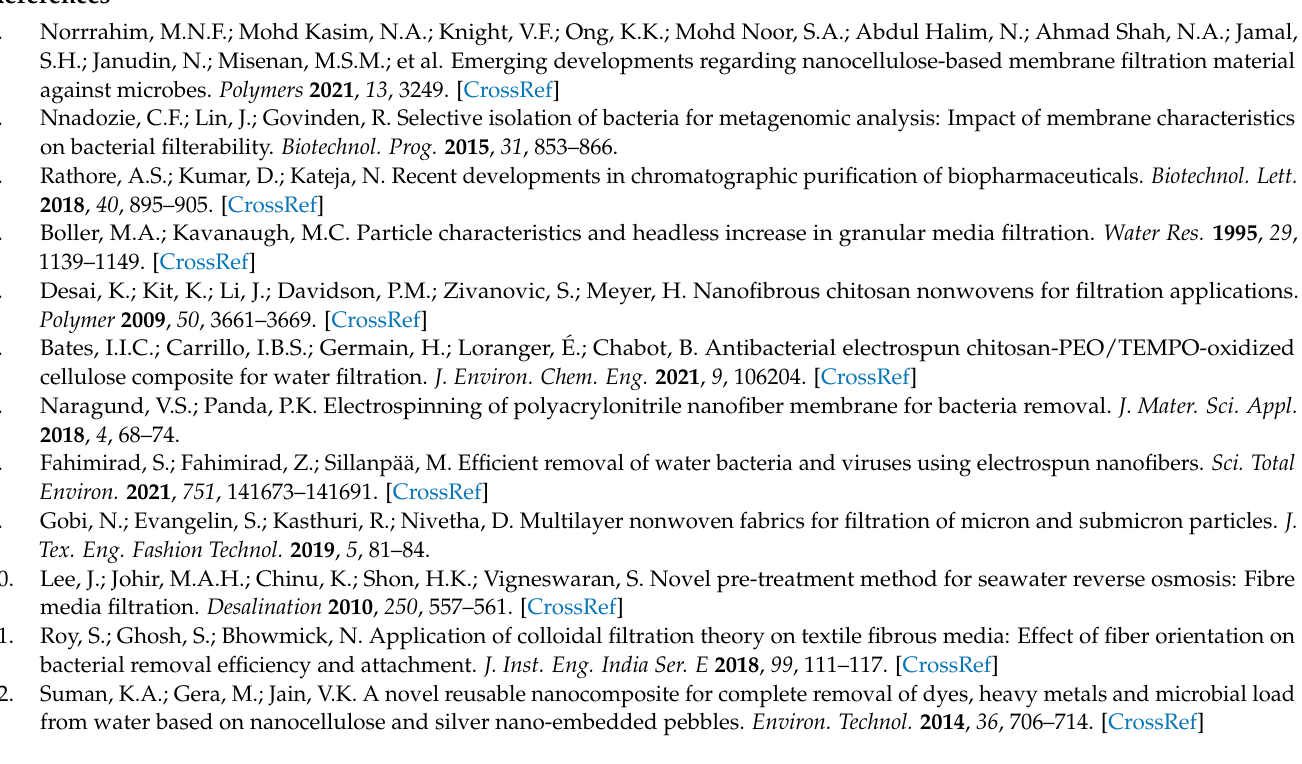
(A) Escherichia coli (EXB-V127), (B) Staphylococcus aureus (EXB-V54), and (C) Micrococcus luteus (EXB-V52); Figure S3: Four individual (i.e., single-layer) fibrous membranes of the same type (each impregnated with 50 mL of 0.1 wt% quaternised cellulose nanofibrils) tested as 4-layer sandwich- structured membranes in a vacuum filtration performance assay with bacterial cell suspensions of (A) Micrococcus luteus (EXB-V52) and (B) Escherichia coli (EXB-V127); Figure S4: Four individual (single-layer) fibrous membranes (each impregnated with 50 mL of 0.1 wt% quaternised cellulose nanofibrils (qCNF), with and without the addition of 0.1, 0.2 or 0.3 wt% amino-hydrophobised CNF (aCNF)) after testing as 4-layer sandwich-structured membranes in a vacuum filtration performance assay with bacterial cell suspension of (A) Escherichia coli (EXB-V127) and (B) Staphylococcus aureus (EXB-V54); Table S1: Overview of the final nominal concentrations of the quaternised (qCNF) and amino-hydrophobised cellulose nanofibrils (aCNF) suspensions used in the broth macrodilution assay with the Gram-negative (G-) bacterial strain Escherichia coli (EXB-V127) and the Gram-positive (G+) bacterial strain Staphylococcus aureus